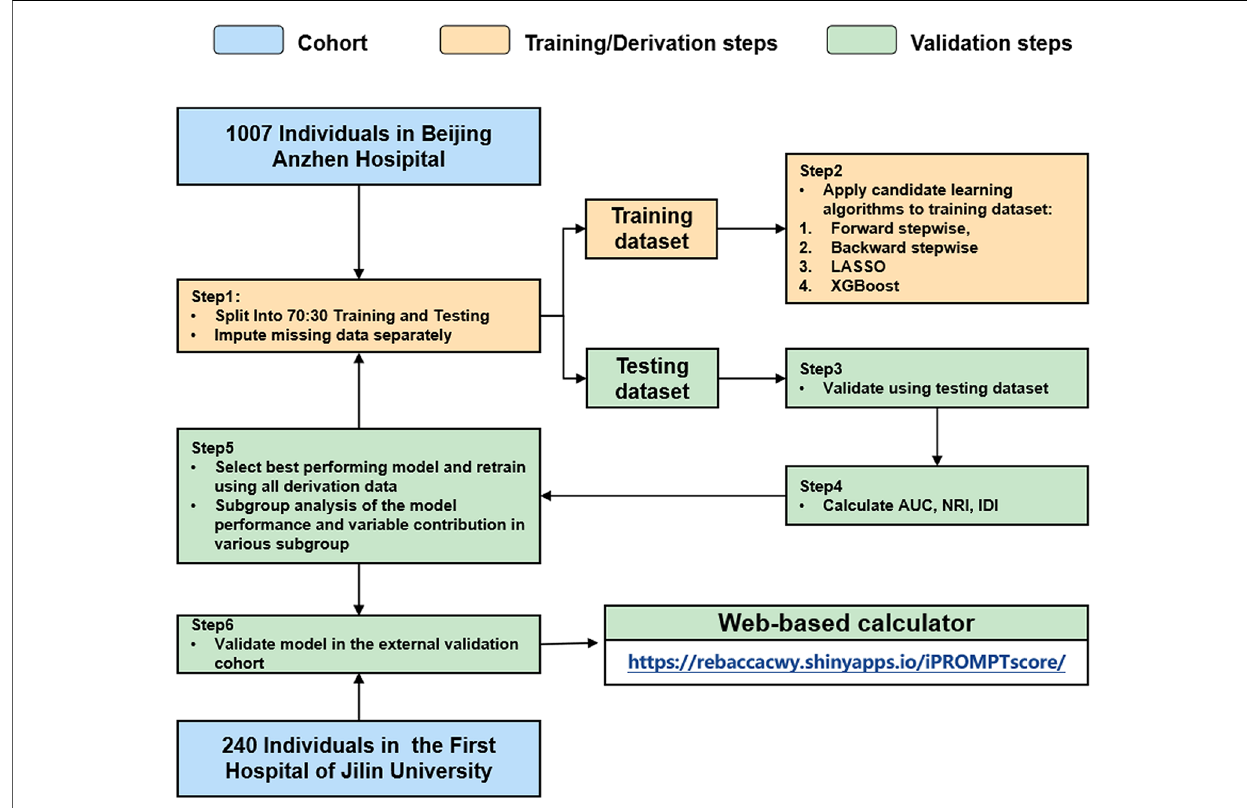
FIGURE 1 Analysis overview for identifying best-performing risk prediction model. AUC, area under the curve; NRI, net reclassi fi cation index; IDI, integrated discrimination